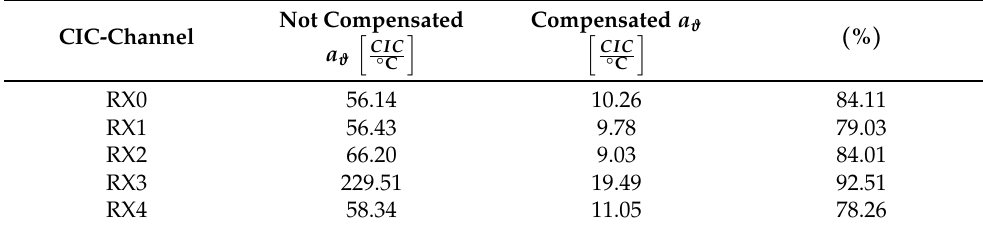
Table 3. Temperature coefficient with and without temperature compensation and improvement in